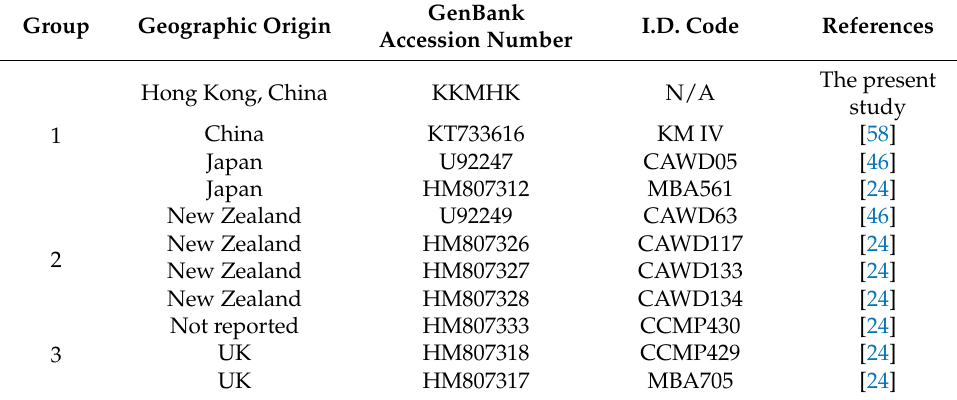
Table A3. LSU, ITS1-5.8S-ITS2 and rbc L DNA sequence data of Karenia mikimotoi species used in the phylogenetic study. The nucleotide difference was based on Hong Kong strain KMHK.